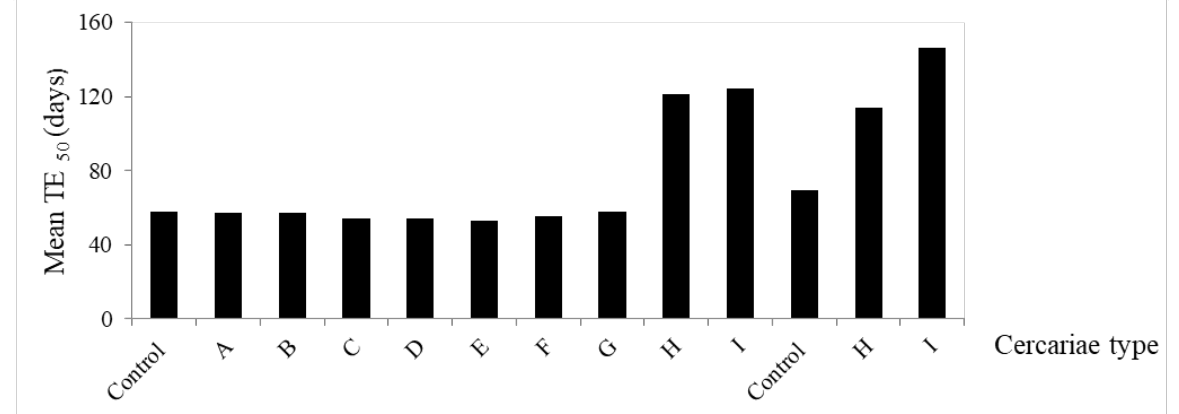
) of Polypedates cruciger exposed to different 50